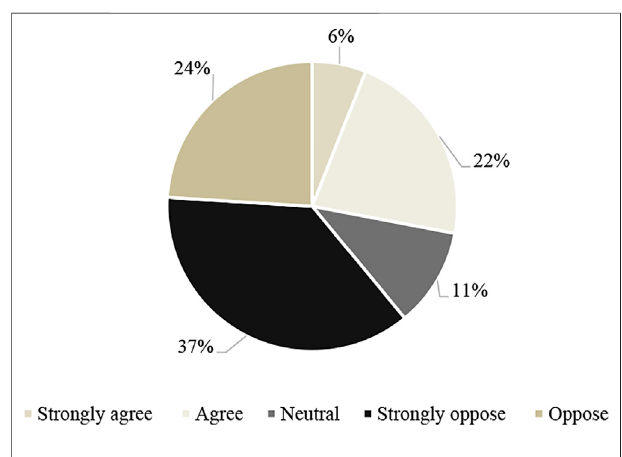
FIGURE 5 | Perspectives on the trade-off between economic development and wetland conservation of